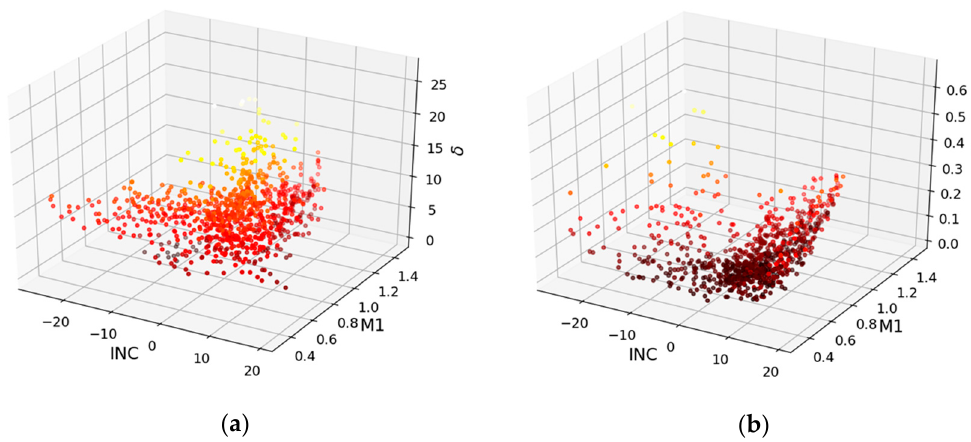
Figure 2. Structure of surrogate models.